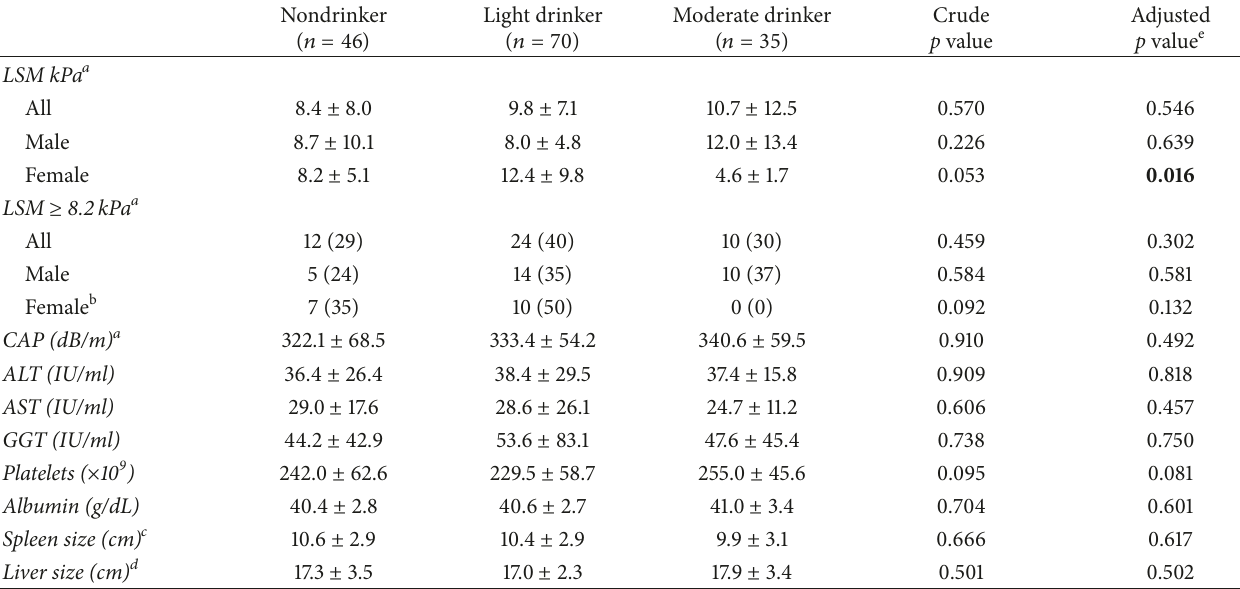
Table 2: Liver stiffness measurements and selected biochemical, hematological, and liver imaging parameters according to lifetime drinking